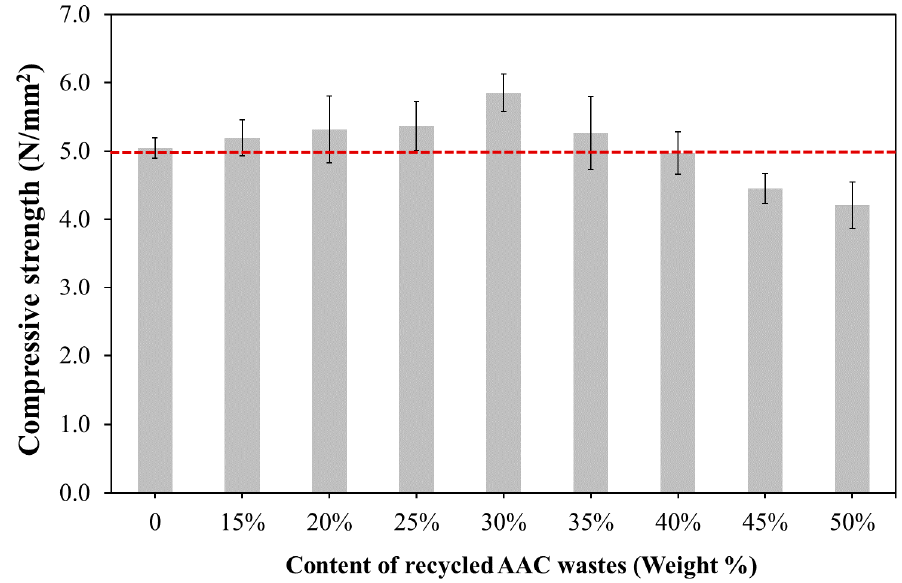
Figure 3. Compressive strength of AAC with different content of fine AAC-R wastes (the red dash line indicates the minimum acceptable value of compressive strength according to ASTM C1692- 18).